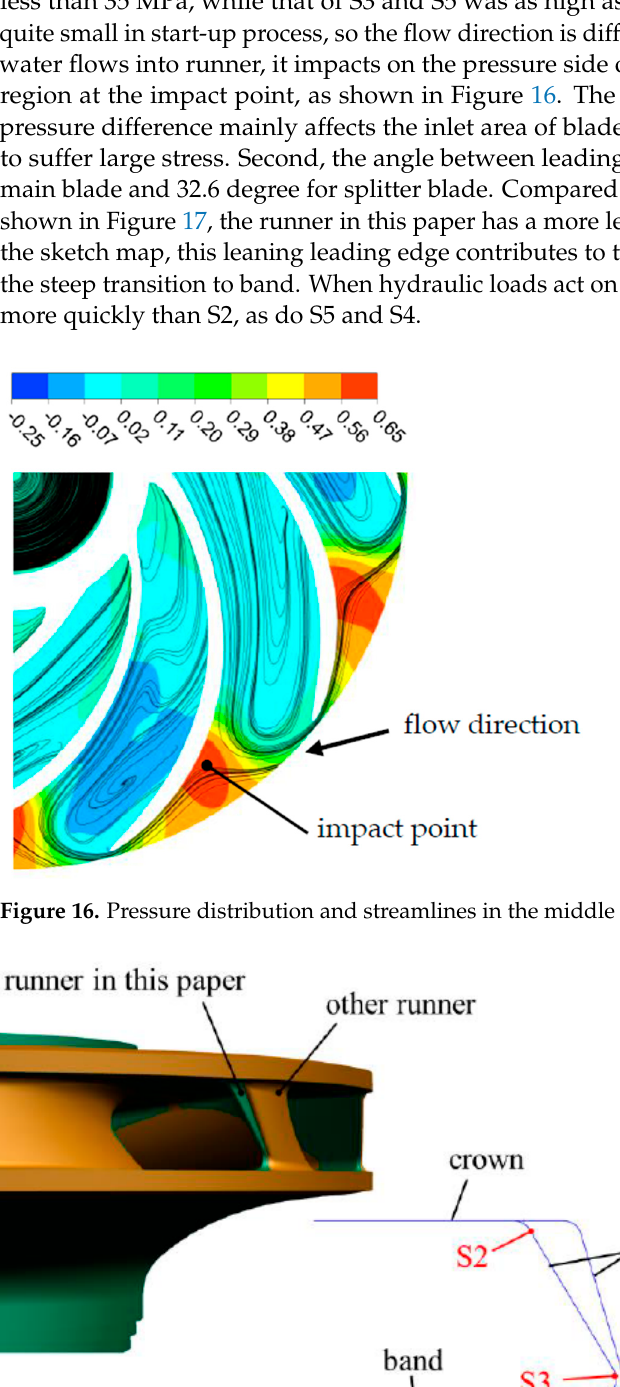
Figure 15. Axial forces of runner.